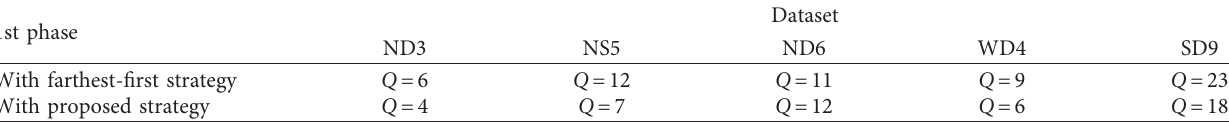
Table 4: Number of queries from oracles in the first